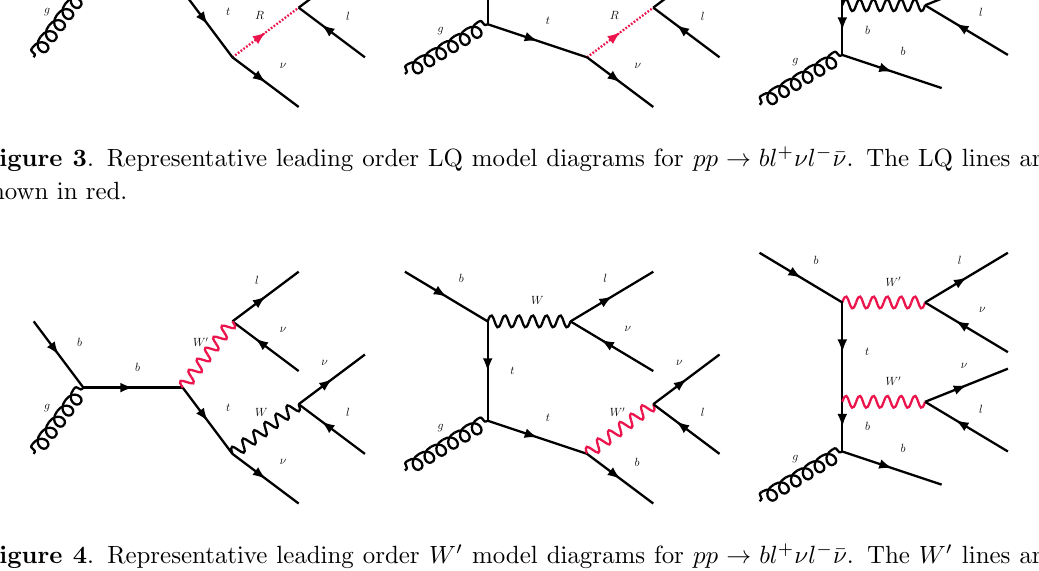
Figure 4 . Representative leading order W 0 model diagrams for pp shown in red.